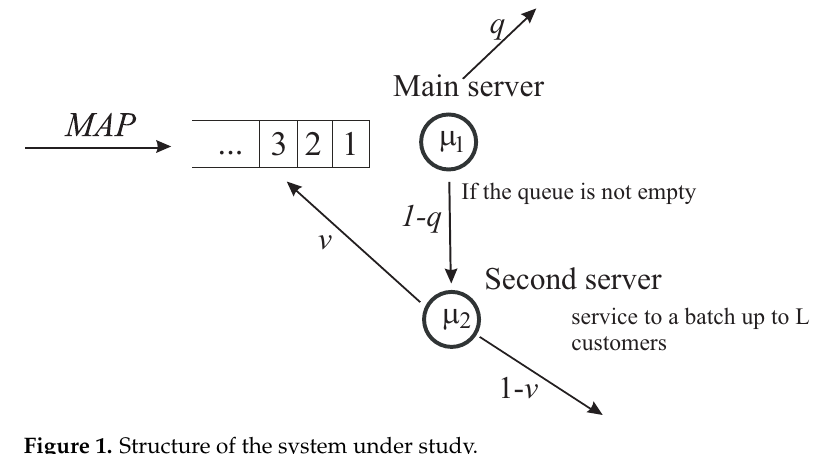
Figure 1. Structure of the system under